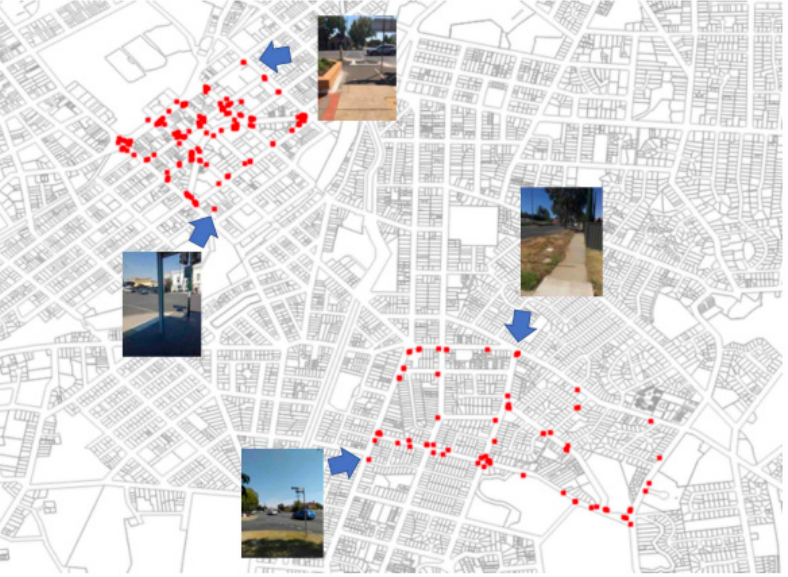
Figure 6. Images captured by the volunteers from the visited routes.